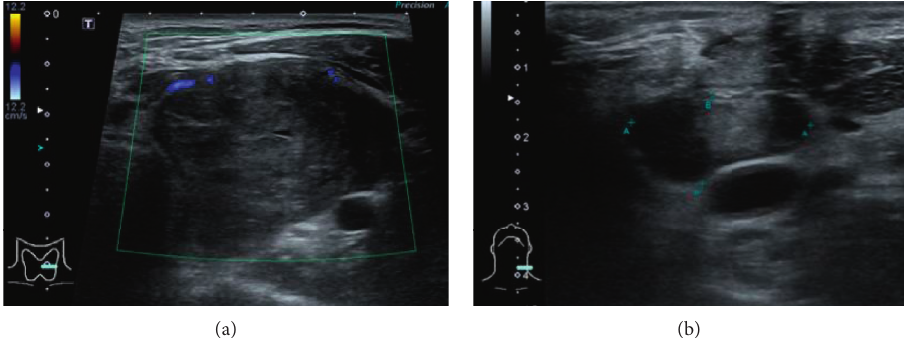
Figure 3: Ultrasound of the thyroid gland showing (a) a large heterogenic hypoechoic mass occupying the entire left thyroid lobe with no hypervascularity and (b) an enlarged left cervical lymph node with cystic